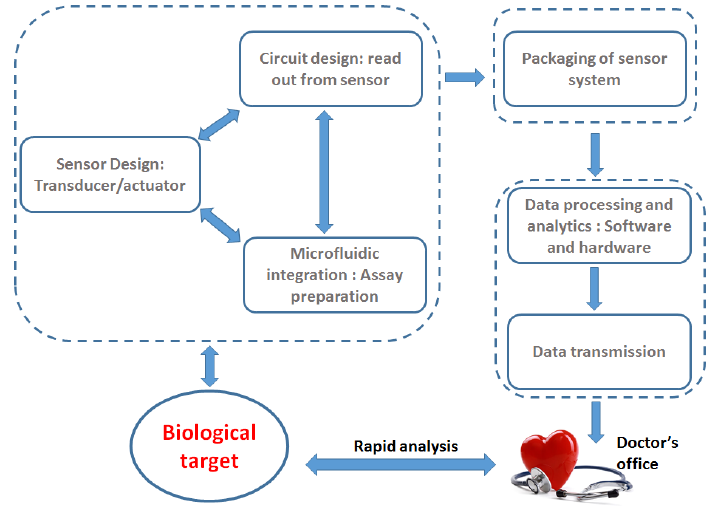
Figure 2. Key features of POCT system. The efficient design of POCT system requires the interaction of life science, chemistry, microsystems, sensor design, circuit design, packaging, and data analytics.